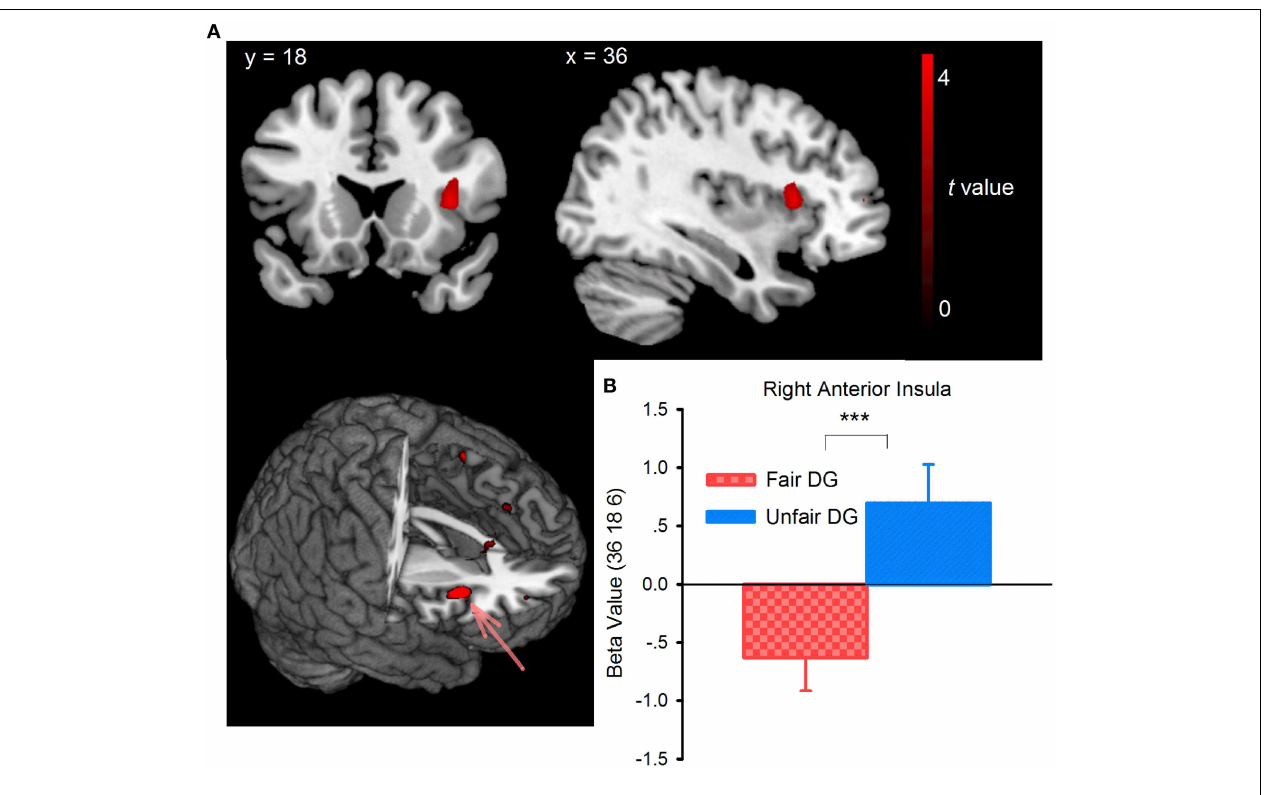
the activation maximum within an 8-mm sphere around the right anterior insula ROI, whose coordinates were derived from previous studies ( Sanfey et al., 2003). ∗∗∗ p < 0 . 001